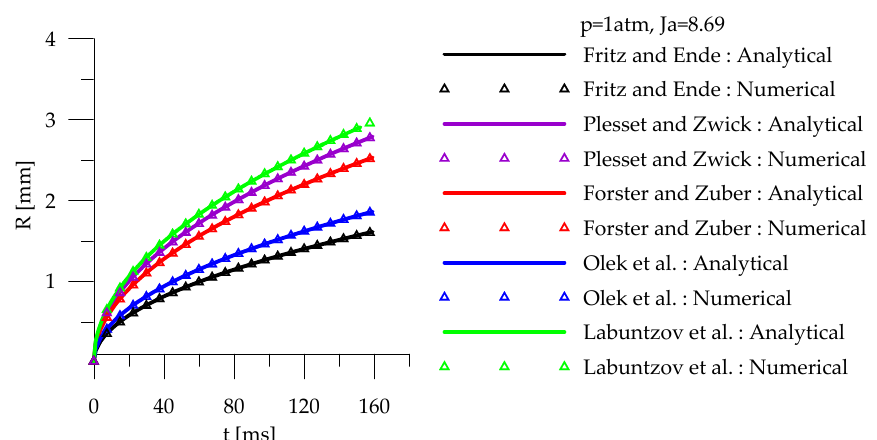
Figure 8. Numerical and analytical solution of bubble growth at zero gravity ( T sup = 2.9